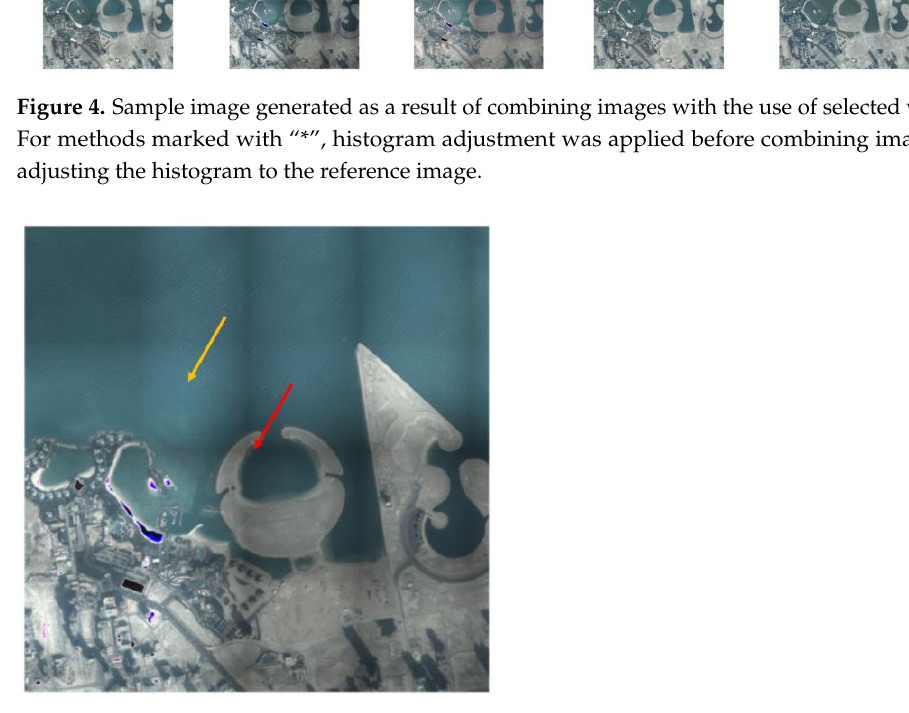
Figure 5. Fragment of the resulting image that was generated with the use of the Lanchos window. The lighter stripe of pixels that shows that the sum of weights is higher than 1 and is marked with the yellow arrow, while the red arrow indicates the stripe of darker pixels, where the sum of weights is lower than 1.